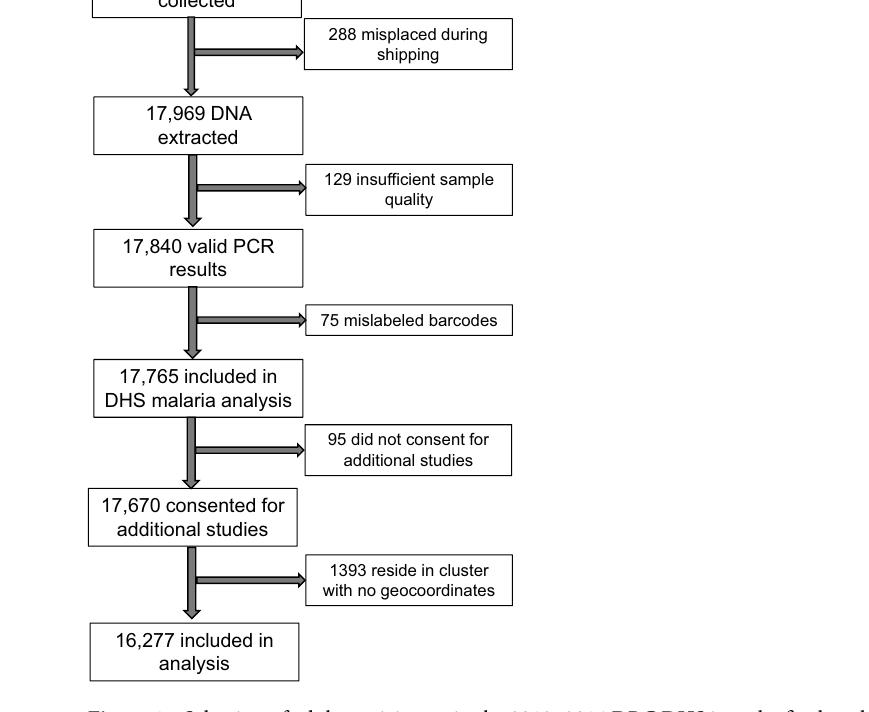
Figure 1. Selection of adult participants in the 2013–2014 DRC DHS into the final